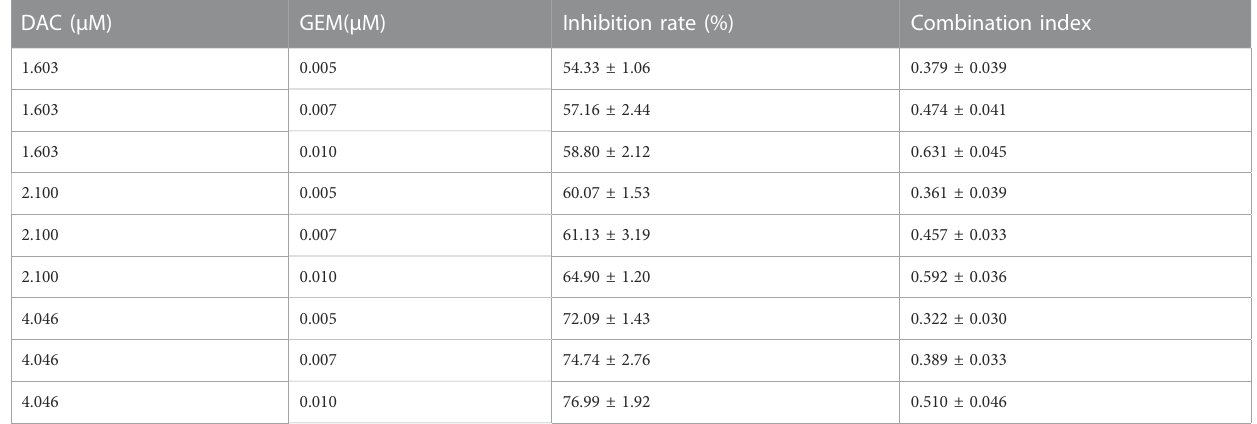
TABLE 2 Proliferation inhibition rate or combination index of NK92MI cells treated with different concentrations of DAC and